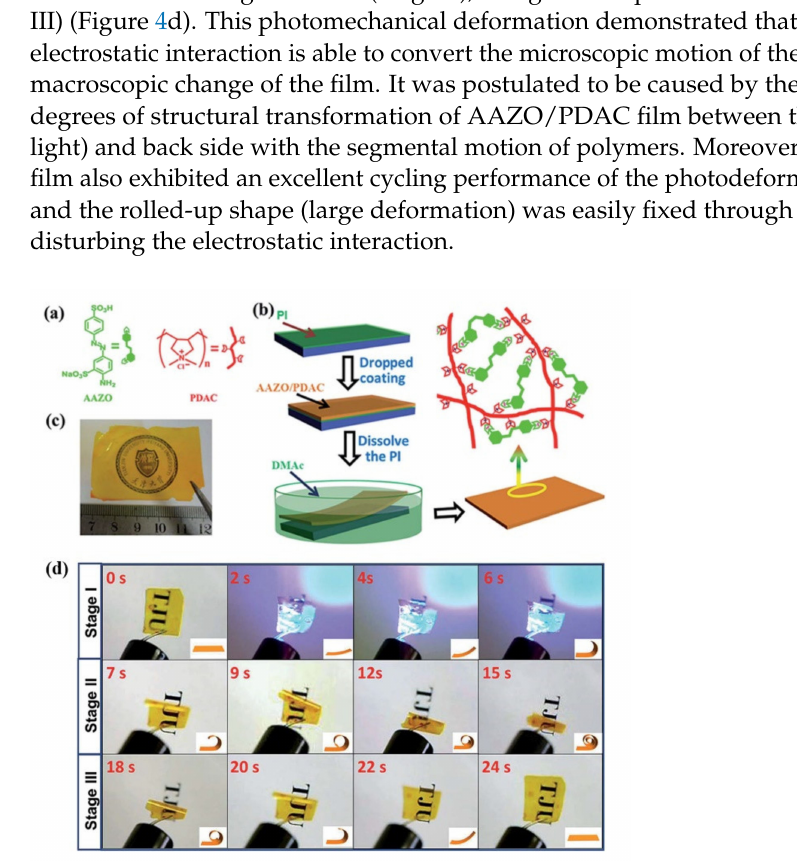
Figure 4. ( a ) Chemical structures of AAZO and PDAC. ( b ) Schematic illustration of the preparation and structures of the AAZO/PDAC film. ( c ) Optical image of a free-standing AAZO/PDAC film with an area of 5 cm × 3.2 cm. ( d ) Photographic frames of the light-driven deformation and shape recovery of the AAZO/PDAC film. The film (10 mm × 15 mm) was held vertically with one side clamped. The UV light (30 mW cm − 2 ) is switched on in stage I and switched off in stage II and stage III. The inset of each photograph is a schematic illustration of the film. Reprinted with permission from Reference [48]. Copyright 2015 Royal Society of